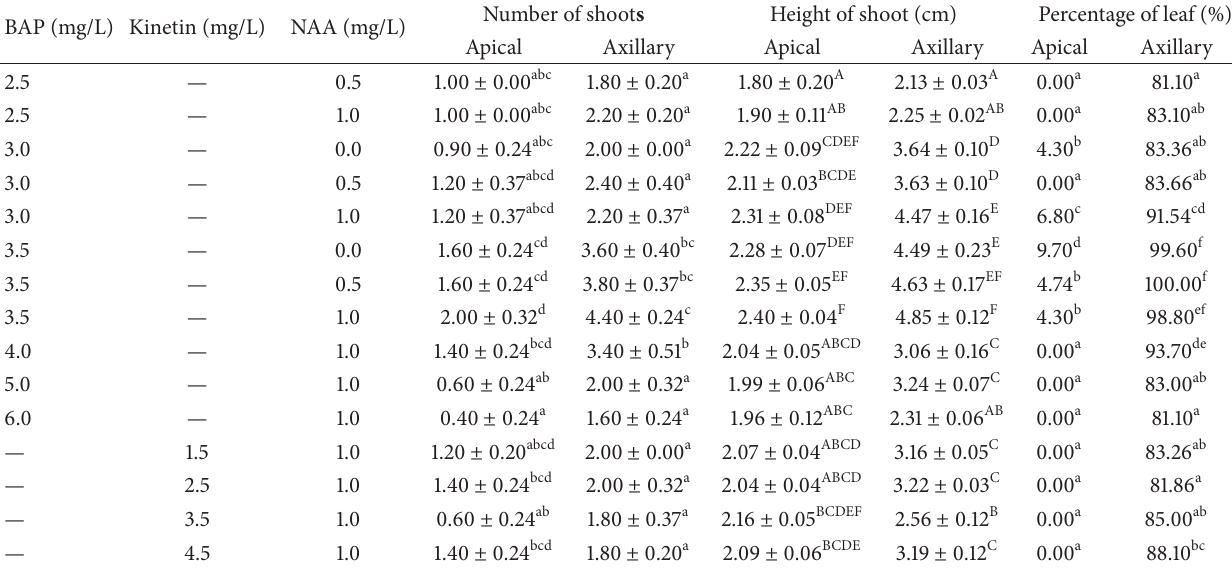
Table 4: Effects of different concentrations and combinations of cytokinin and auxin on shoot production from two different sources of explants in red C. Crotalifera